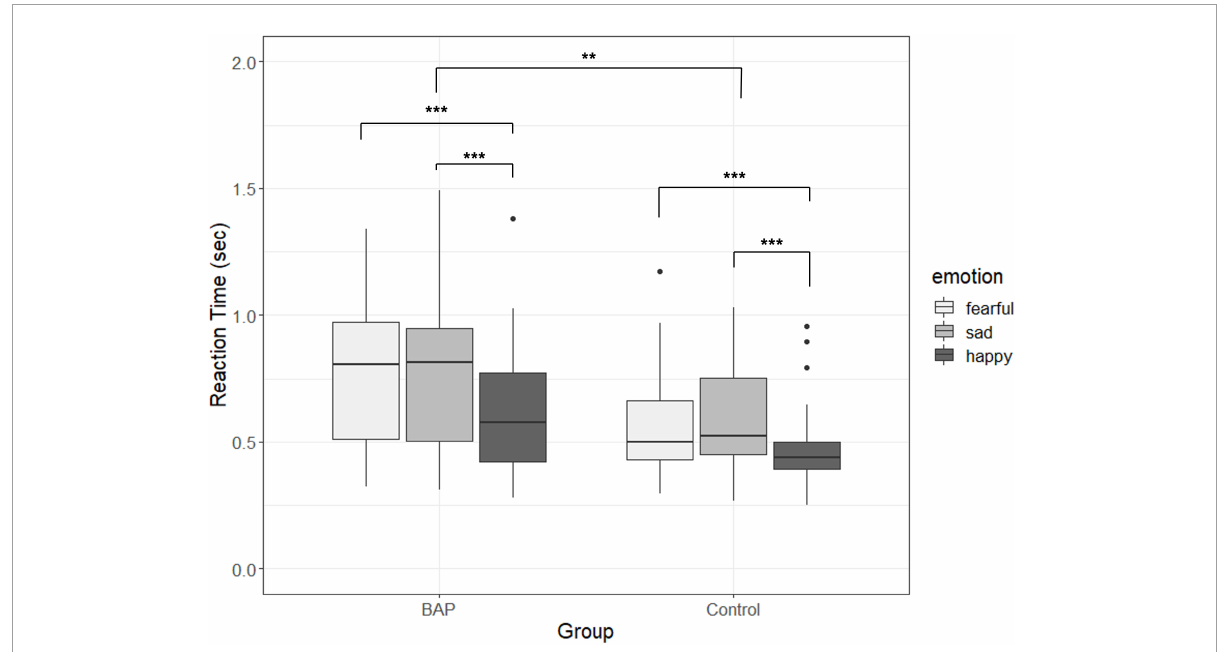
FIGURE3 Comparison of reaction time for emotion in the broad autism phenotype (BAP) and control groups. Box plots show the median as the middle box line, the first quartile (Q1), and third quartile (Q3) as box edges (denoting the interquartile range, IQR), whiskers as the minimum/maximum points and outliers based on thresholds < Q1–1.5 (IQR) or > Q3+1.5 (IQR). BAP, broad autism phenotype group; Control, control group. ** p < 0.01. *** p < 0.001.